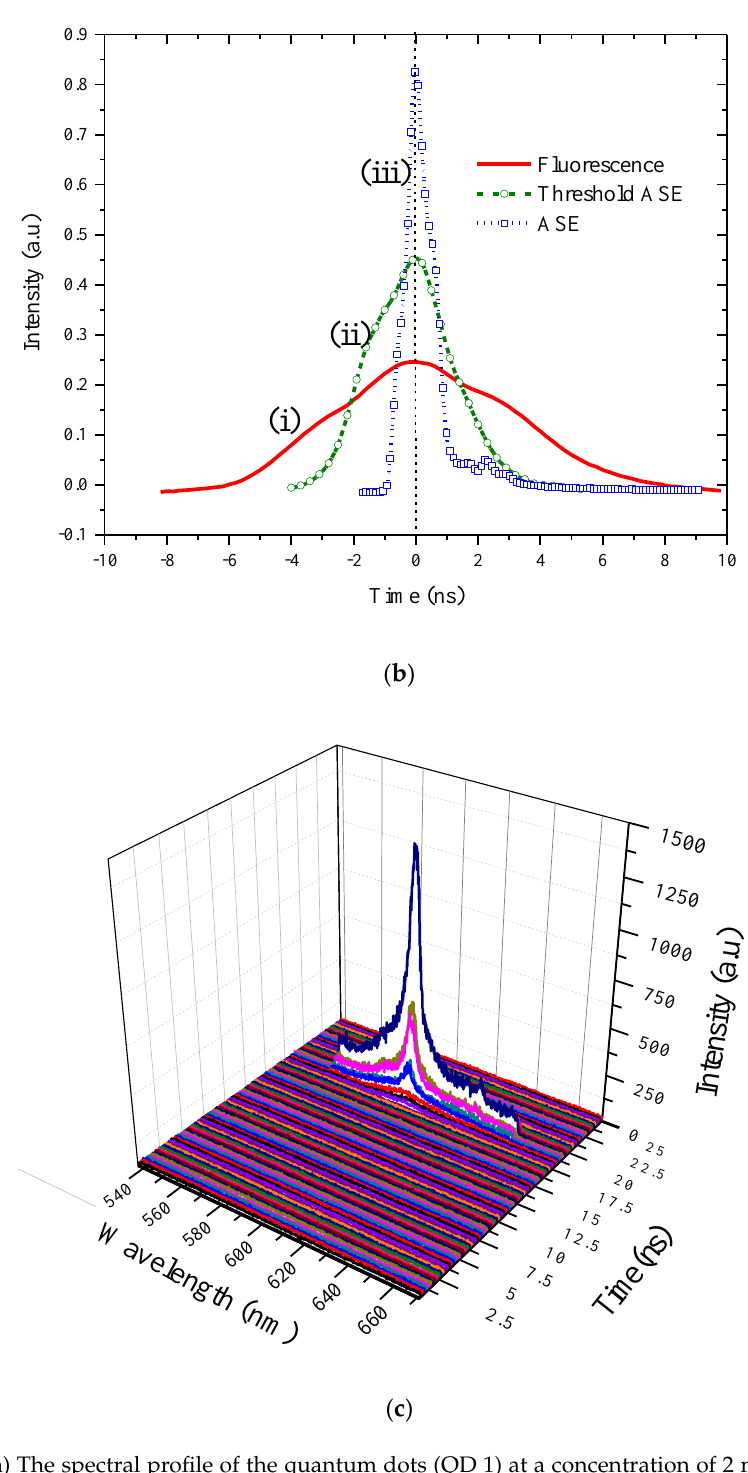
Figure 3. ( a ) The spectral profile of the quantum dots (QD 1) at a concentration of 2 mg in 5 mL of THF; ( b ) The temporal profile of the quantum dots (QD 1) at a concentration of 20 mg in 5 mL of THF; ( c ) Depicts the three dimensional (3D) temporal and spectral profile for another quantum dot (QDs 5, 609 nm) at 24 mg in 5 mL of THF. To differentiate one time frame from other, difference color line are used, each frame represent 0.25 ns.